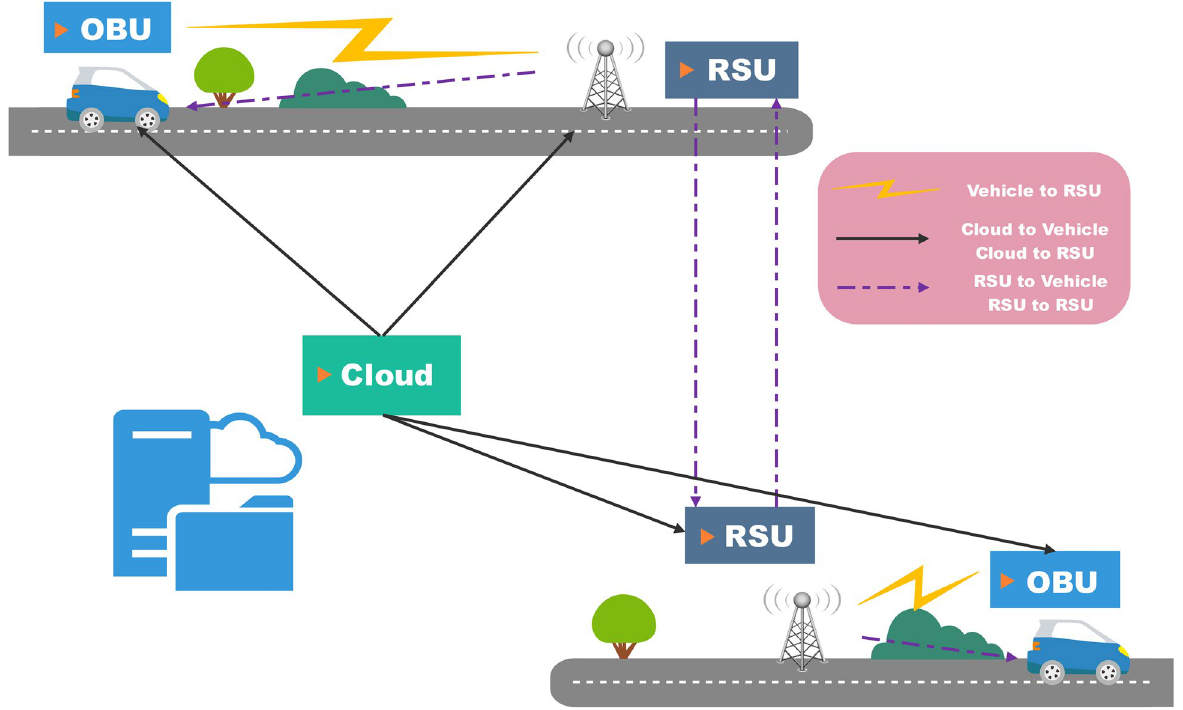
Figure 2 depicts cloud-edge communication scenar- ios, where OBUs and RSUs act as edge devices and they communicate with the cloud.